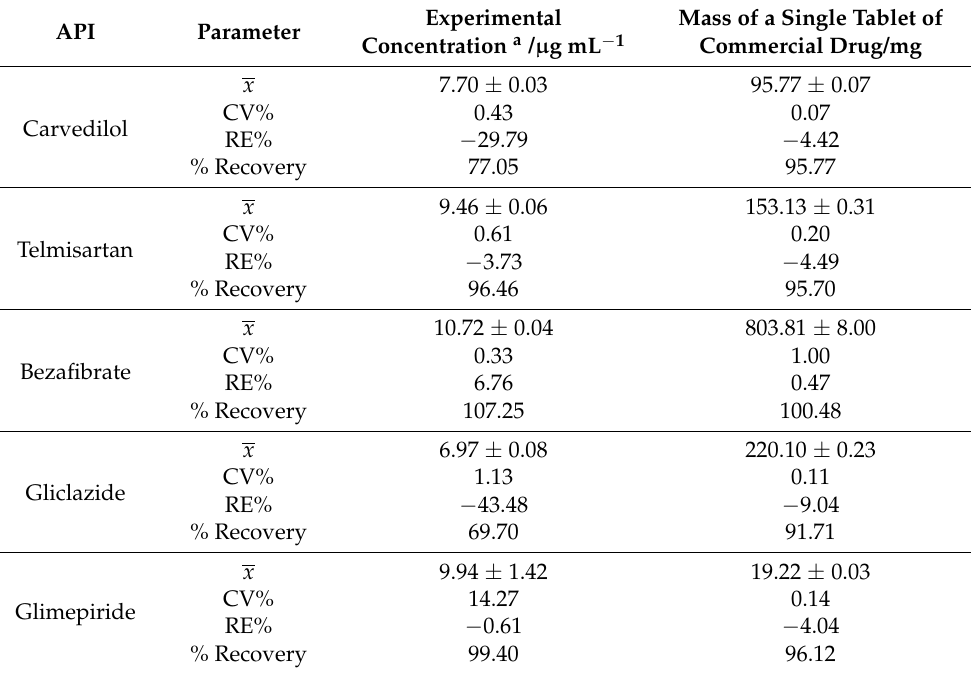
Table 4. Evaluation of experimental concentration and mass of active pharmaceutical ingredients (API) from sample solutions prepared with commercially available drug products.